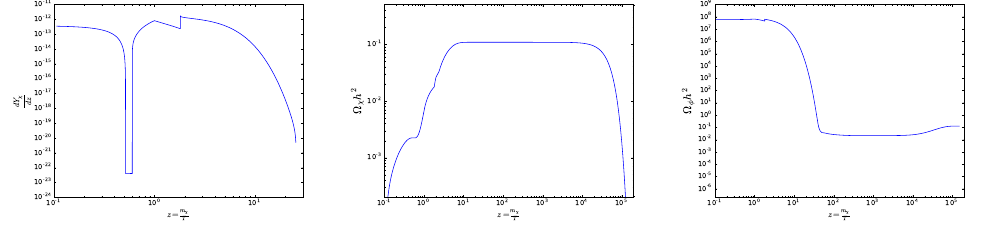
Figure 6 . The evolution of the number densitys of (cid:31) and (cid:30) for m (cid:30) < m (cid:31) with m (cid:30) = 110 GeV, (cid:21) h(cid:30) ( (cid:21) (cid:30) ) = 0 : 45(1), m (cid:31) = 180 GeV, and m N = 20